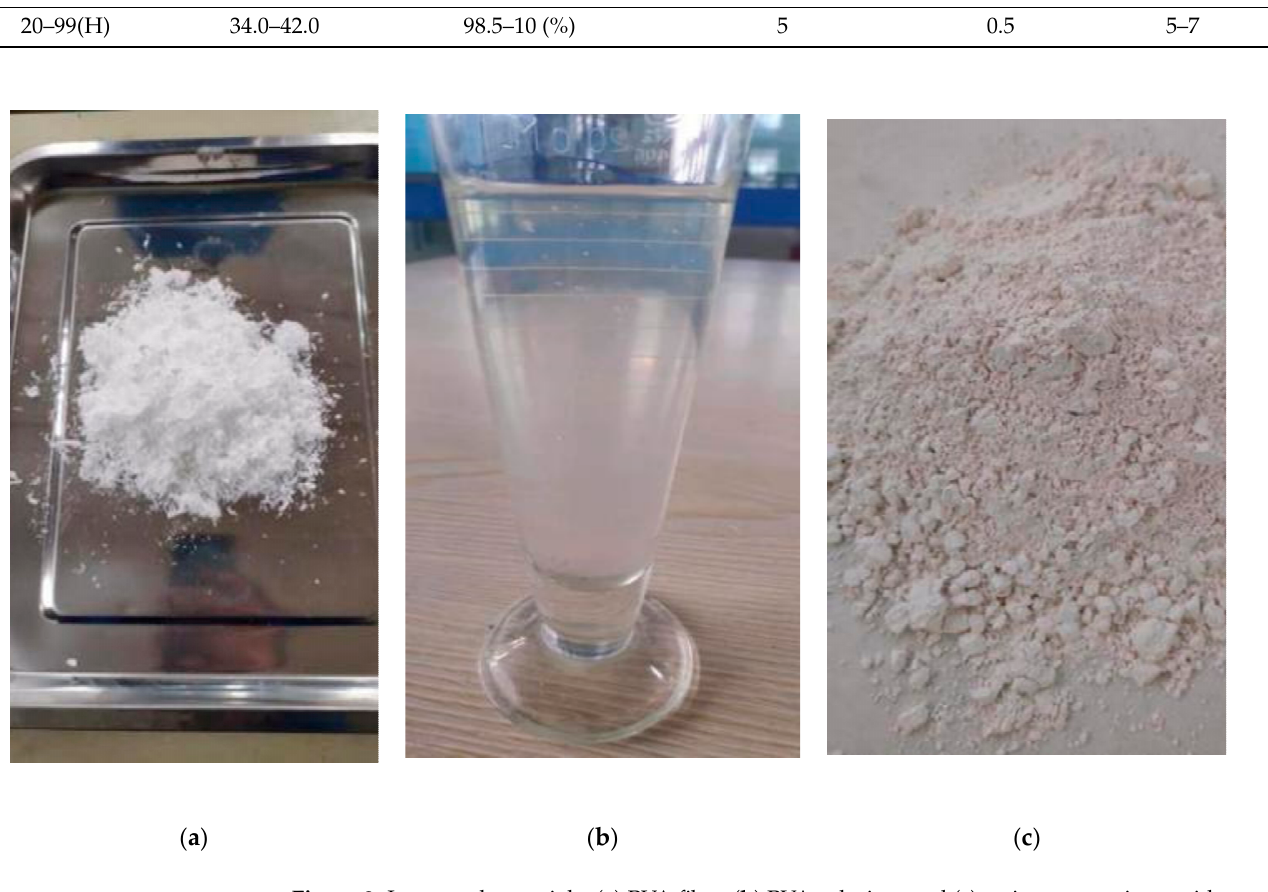
Figure 2. Improved materials: ( a ) PVA fiber, ( b ) PVA solution, and ( c ) active magnesium oxide.